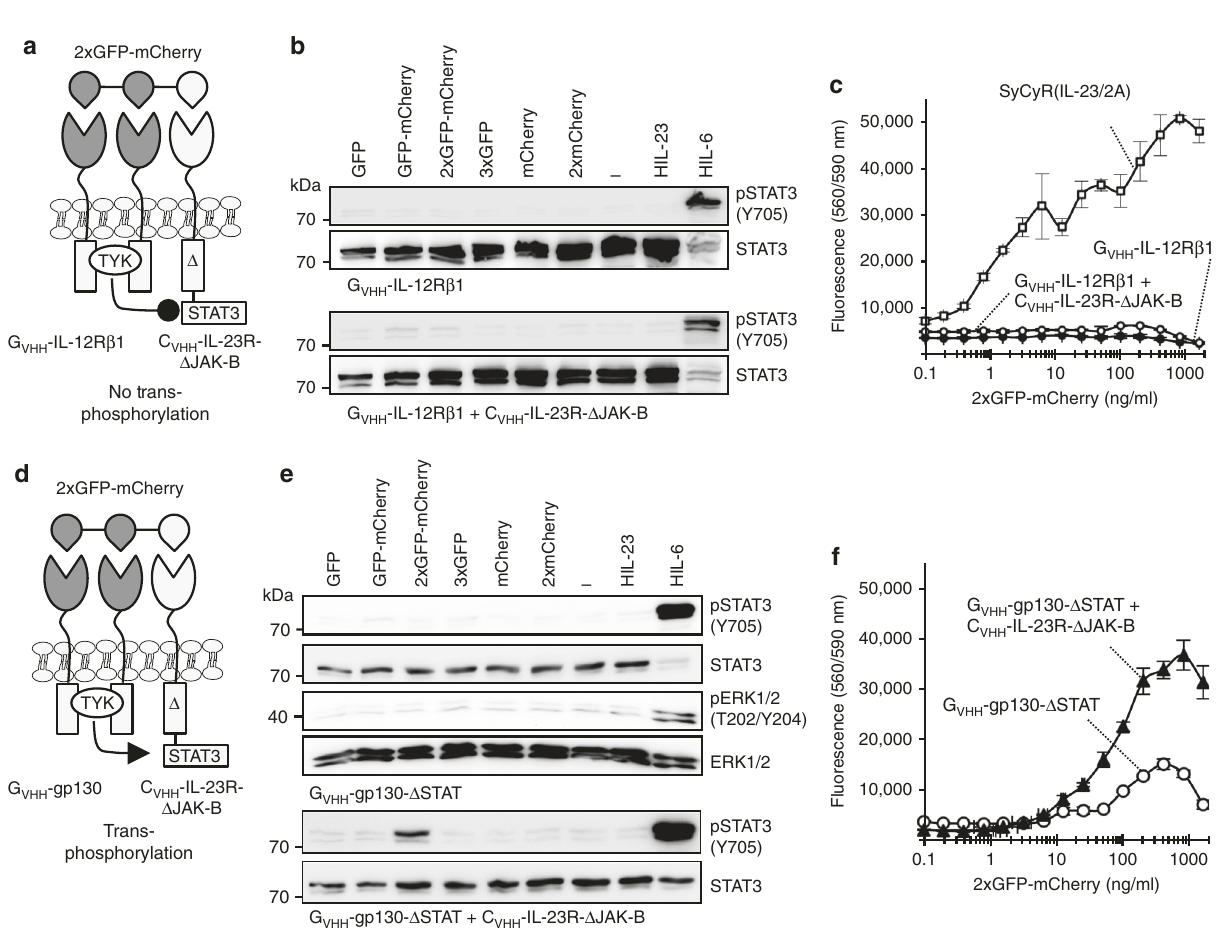
Imaging Instruments GmbH, Göttingen, Germany) were used for signal detection. For re-probing with another primary antibody, the membranes were stripped in 62.5mM Tris-HCl (Carl Roth, Karlsruhe, Germany) pH 6.8, 2% SDS (Carl Roth, Karlsruhe, Germany) and 0.1% β -mercaptoethanol (Sigma Aldrich, Munich, Ger- many) for 30 min at 60 °C and blocked again. The band intensities of the western blots (Fig. 4f) were quanti fi ed using ImageJ software. Uncropped images of western blots are presented in Supplementary Fig. 13. Cell surface detection of cytokine receptors . To detect cell surface expression of the synthetic cytokine receptors, stably transduced Ba/F3-gp130 cells were washed with FACS buffer (PBS containing 1% BSA) and incubated at 5× 10 5 cells/100 μ l FACS buffer supplemented with a 1:100 dilution of anti-myc (71D10), (cat. #2278) or 1.2µg anti-Flag (DYKDDDDK) (cat. F7425) mAbs for 1h on ice. After a single